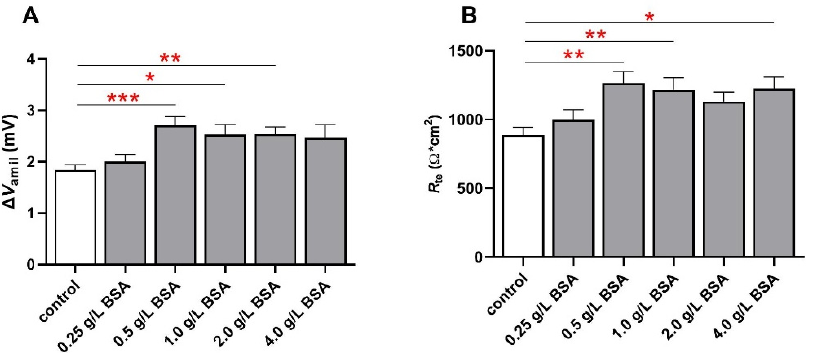
Figure 2. Concentration-dependent effect of BSA. BSA increases epithelial Na + transport after 24 h in a concentration-dependent manner. FDLE cells were cultured in MEM and stimulated with BSA (0.25 to 4.0 g/L) for 24 h. Data are displayed as mean + SEM. ( A ) BSA significantly increased Δ V amil (n = 57–61; * p < 0.05; ** p < 0.01; *** p < 0.001 by one-way ANOVA with Dunnett’s post hoc test). ( B ) BSA further significantly elevated R te in FDLE cells (* p < 0.05; ** p < 0.01 by one-way ANOVA with Dunnett’s post hoc test).